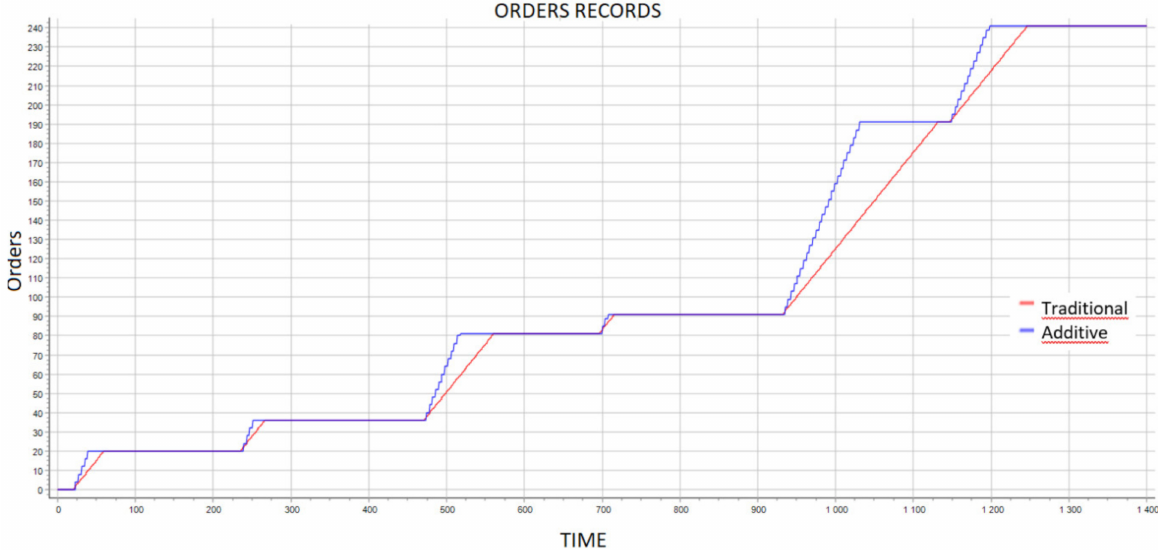
Figure 12. Order record of Demand 1. Source: own elaboration. Evolution software.